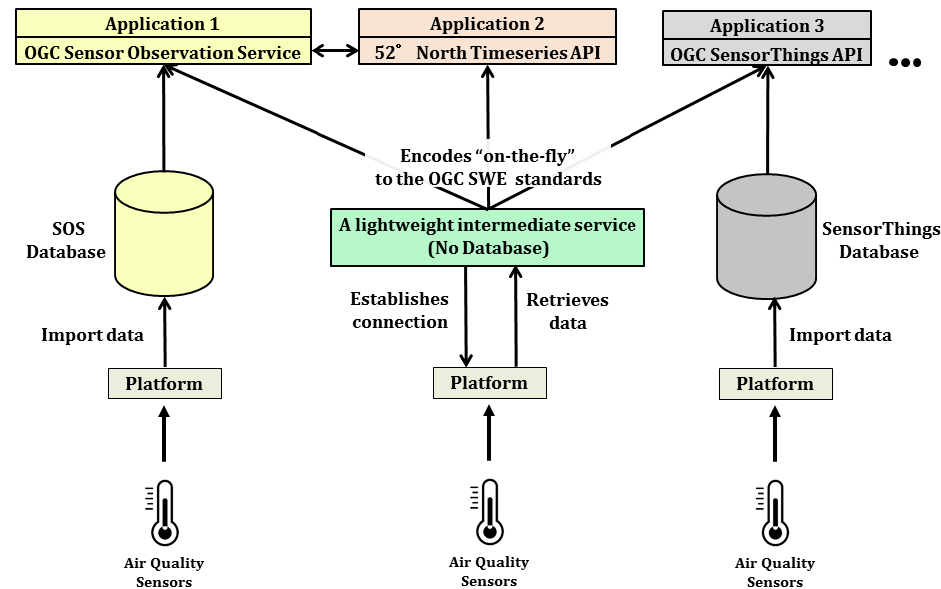
Figure 2. Comparison of the OGC SWE implementations for integrating IoT platforms with them. The implementations of OGC Sensor Observation Service and SensorThings API require importing the observations to their respective data storages. The motivation of this work is a lightweight intermediate service (shown in dark green) allowing connecting to the respective platform, retrieving observations and encoding them “on-the-fly” according to the OGC SWE standardized